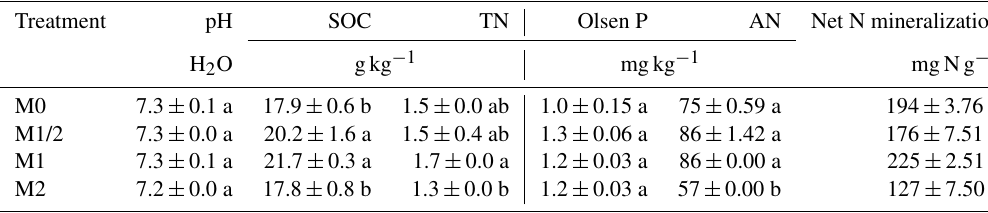
Table 2. Basic description of soil properties under different mowing treatments. Treatment